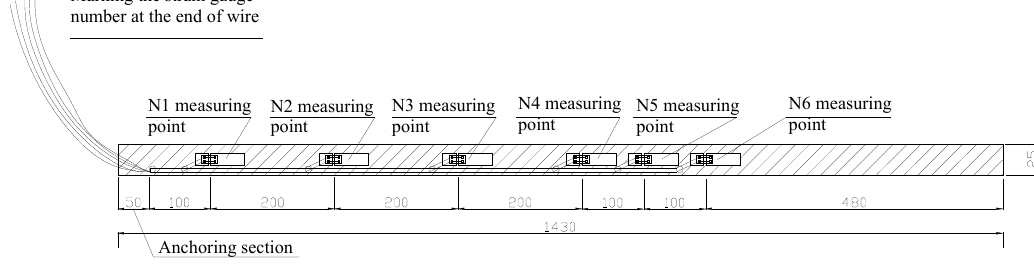
Figure 3. Strain gauge layout (unit: mm).